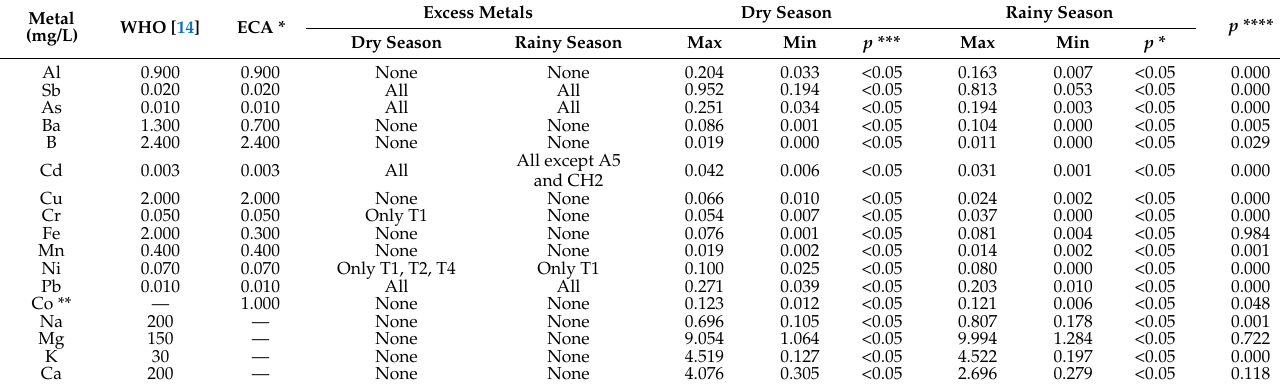
Table 5. Description of the metal levels in water